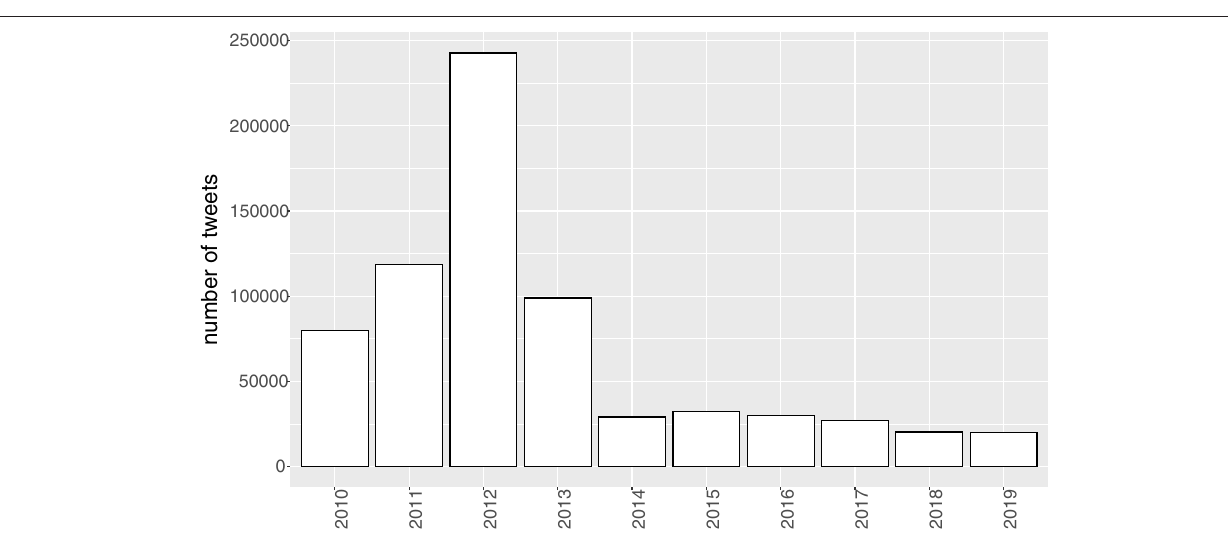
Frontiers in Artificial Intelligence |